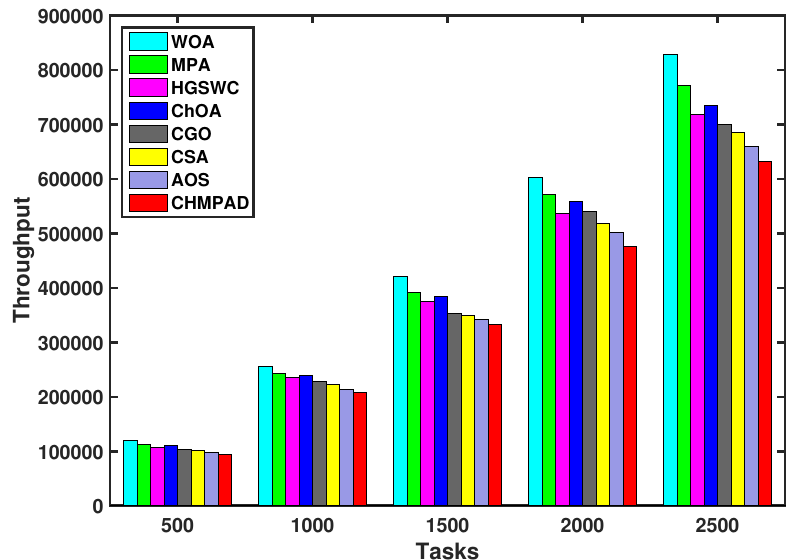
Figure 4. Average throughput time—NASA iPSC workload.